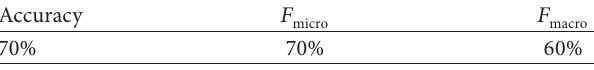
Table 2: Classification performance evaluation results.